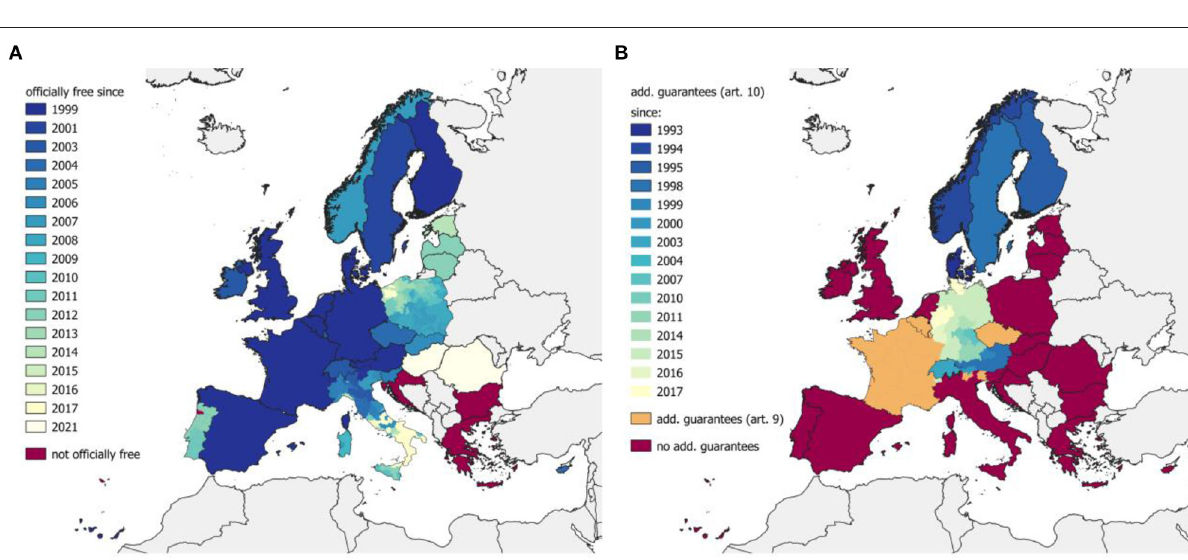
products approx. e 1,260 million, cattle: e 88 million, beef: e 450 million), while the import volume was e 1.17 billion (10, 11). In total, Austria exported 56,173 cattle (10,410 for direct